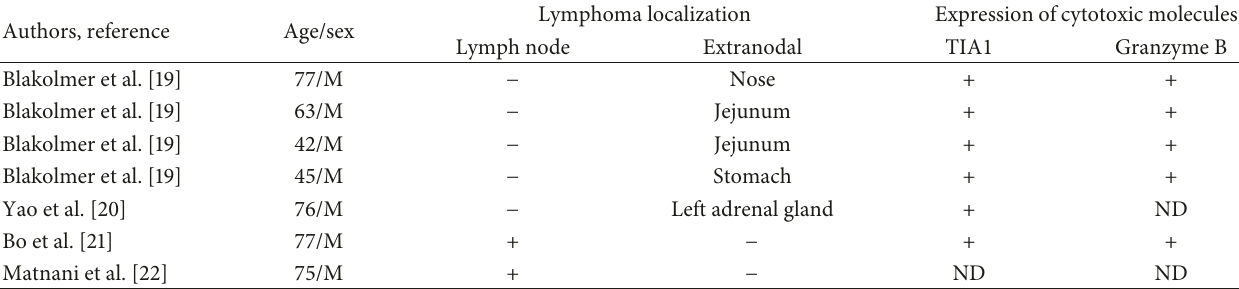
Table 2: Review of the literature for peripheral T-cell lymphomas with aberrant CD79a